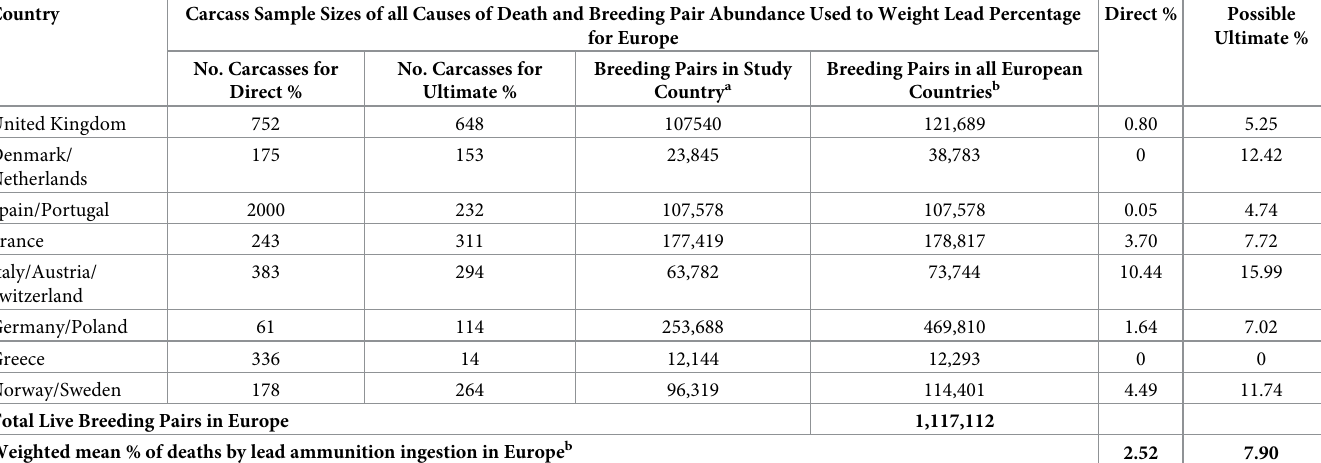
Table 2. Percent of diurnal raptor carcasses that died directly or ultimately of lead ammunition ingestion by country and across Europe. Country Carcass Sample Sizes of all Causes of Death and Breeding Pair Abundance Used to Weight Lead Percentage for Europe No. Carcasses for Direct